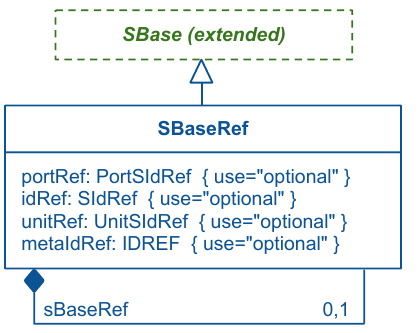
Figure 7: The extensions of the SBaseRef class. The four attributes portRef , idRef , unitRef and metaIdRef are mutually exclusive; only one can have a value in a given object instance. The recursive structure also allows referencing entities in submodels of submodels, to arbitrary depths, as described in the